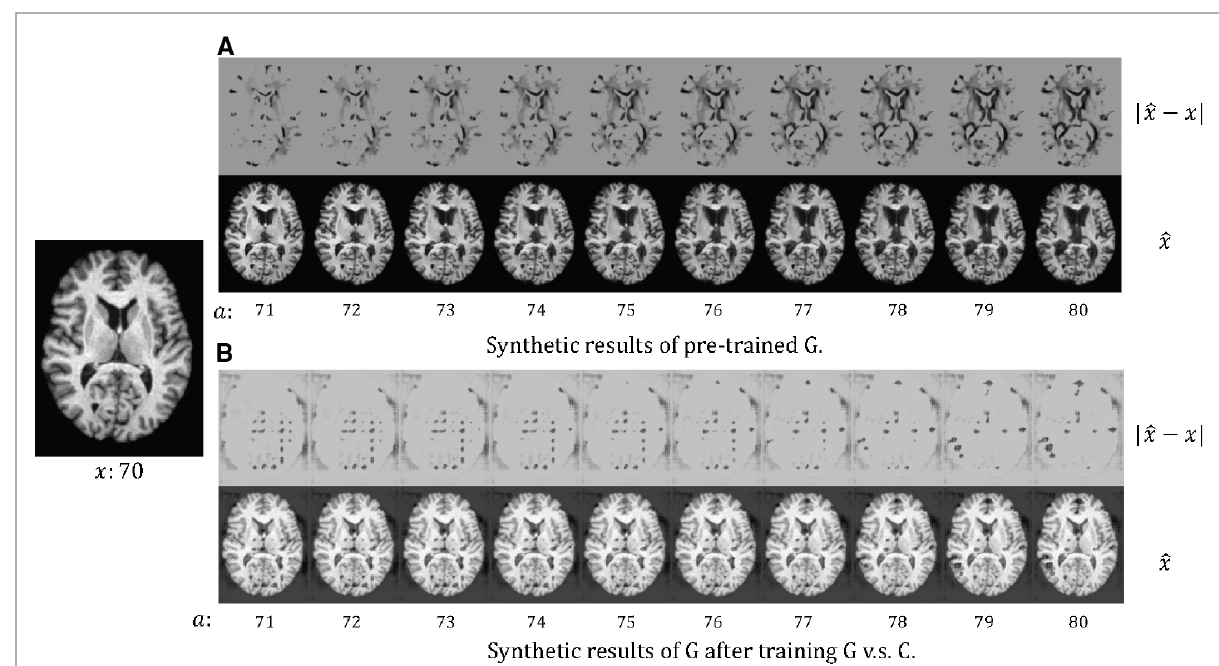
FIGURE 3 The synthetic results for a healthy (CN) subject x at age 70: ( A ) the results of the pre-trained G , i.e. before we train G against C ; ( B ) the results of G after we train G against C . We synthesise aged images ^ x at different target ages a . We also visualise the difference between x and ^ x , j ^ x (cid:4) x j . For more details see